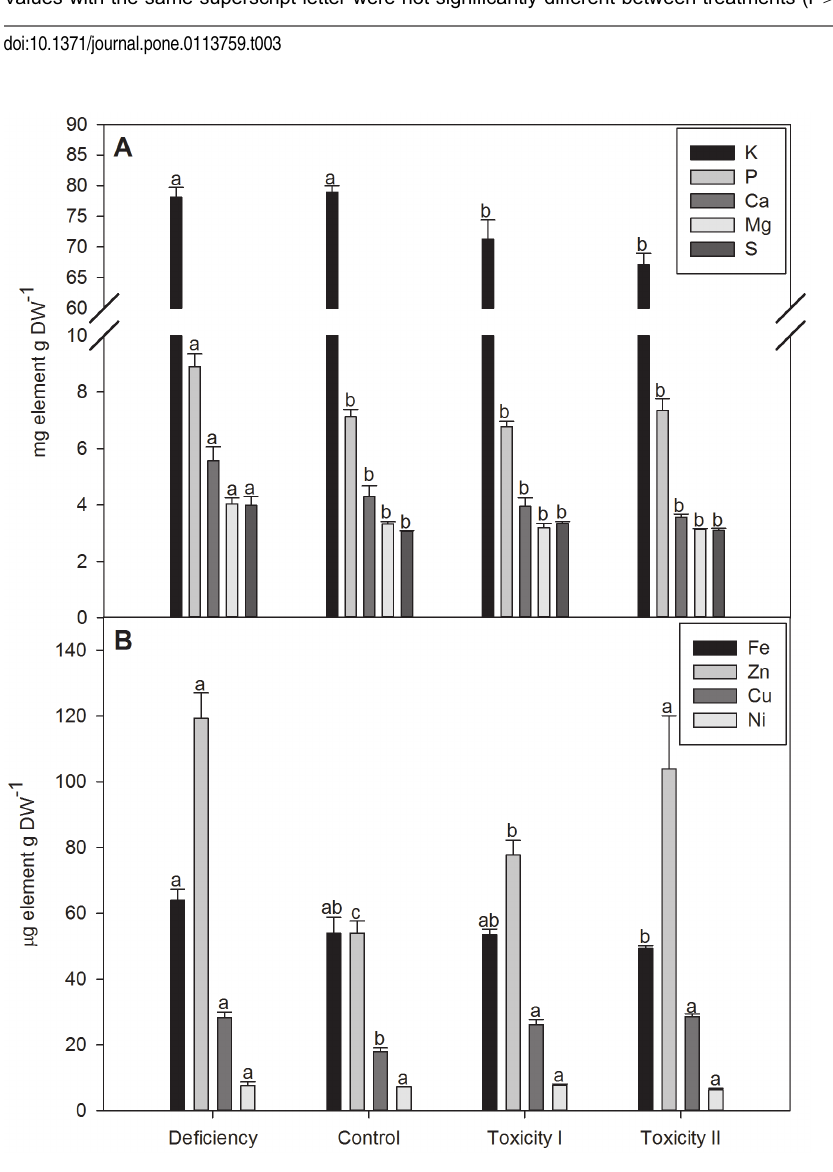
Fig. 5. Elemental analysis of the youngest leaves of barley plants grown with insufficient, control or two increasing Mn toxicity levels. The concentrations of five macro- (A) and four micronutrients (B) were determined in the youngest leaves. Data are means ¡ SE ( n 5 3). Values with the same letter between treatments are not significantly different (P .